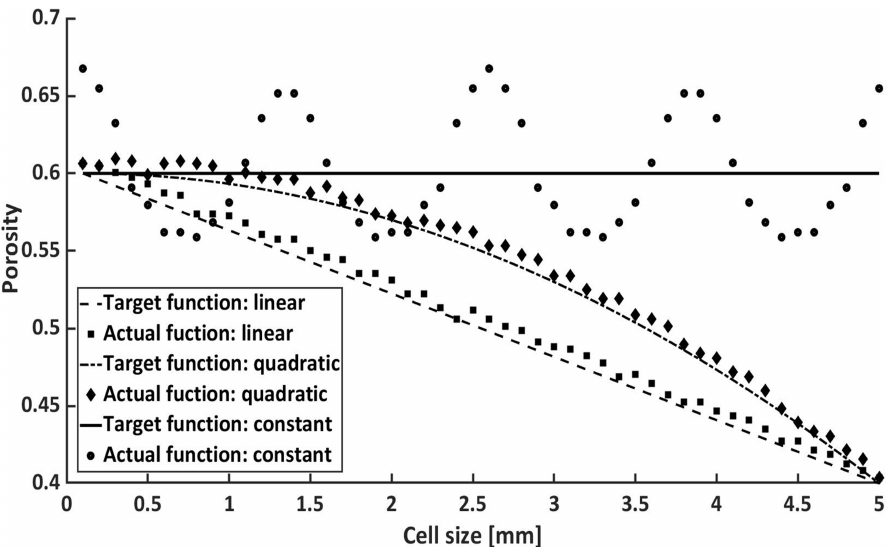
Figure 4. Porosity function of the constant, linear, and quadratic